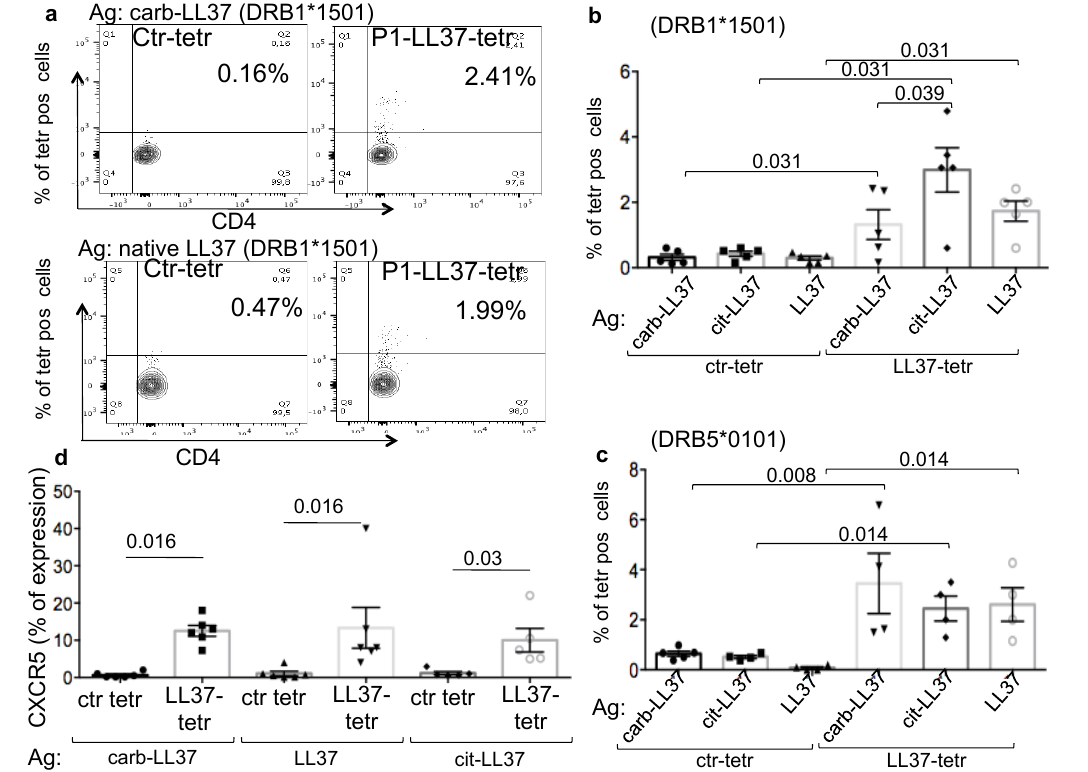
Figure 5. SLE-blood T-cell stimulation with carb-LL37 expands T-cell specific for native LL37. ( a – c ) Peripheral Blood Mononuclear Cells (PBMC) of SLE patients were stimulated by carb-LL37, cit-LL37 or native LL37 as indicated and, after 7 days, T-cells were stained with peptide-MHC-tetramers of HLA-DR15*1501 ( a , b ) or HLA-DRB5*0101 ( c ), loaded with a native LL37 epitope (P1) or a control peptide-MHC-tetramer (see Methods). Cells were analyzed by flow cytometry and percent of peptide-MHC-tetramer staining is reported on the contour plots in ( a ) or on the y -axis in ( b , c ) (cumulative data). ( d ) SLE T-cells were stimulated with carb-LL37, cit-LL37 or native LL37 and percent of expression of CXCR5 on peptide-MHC-tetramer-positive cells was assessed by flow cytometry. In the panels ( a – c ) horizontal bars represent the mean, vertical bars standard errors of the mean, p -values by Wilcoxon’s